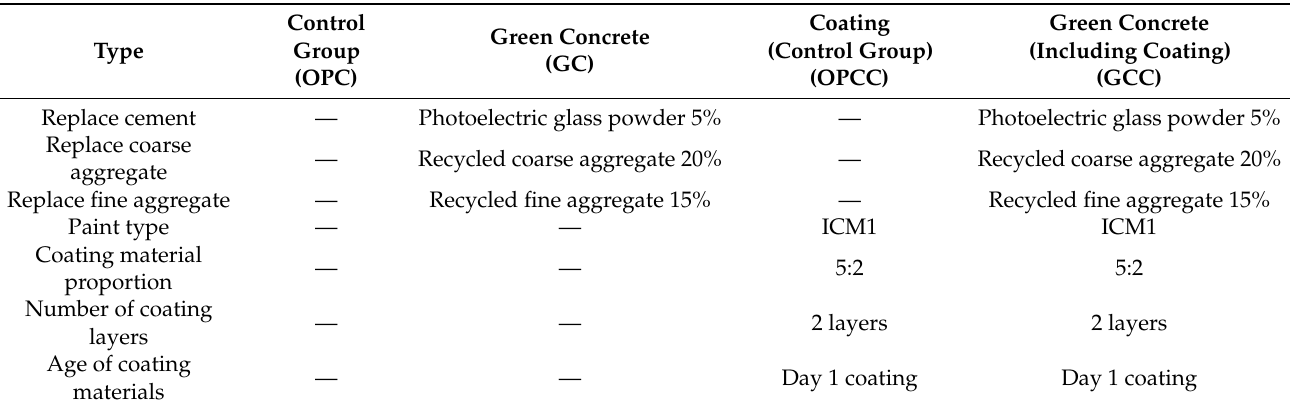
Table 11. Concrete test variables.